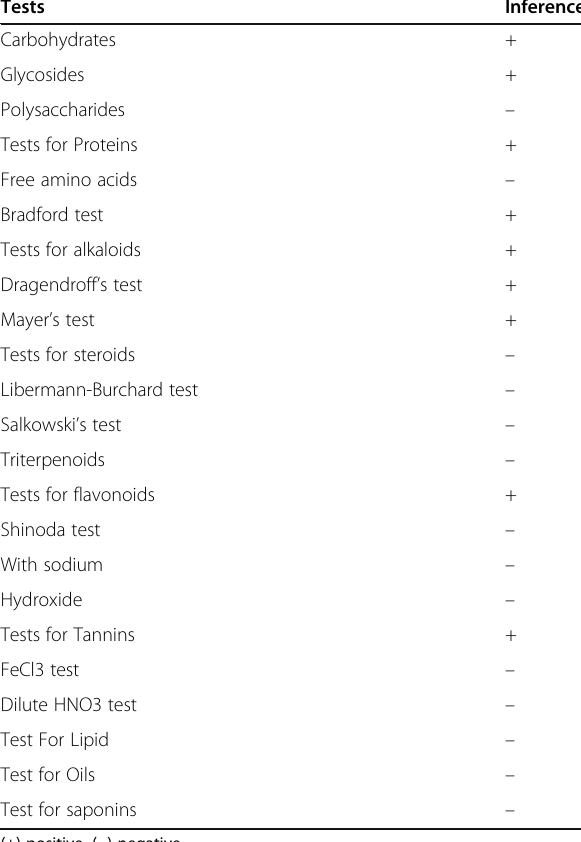
Table 1 Phytochemical analysis of fruit extracts of Martynia annua